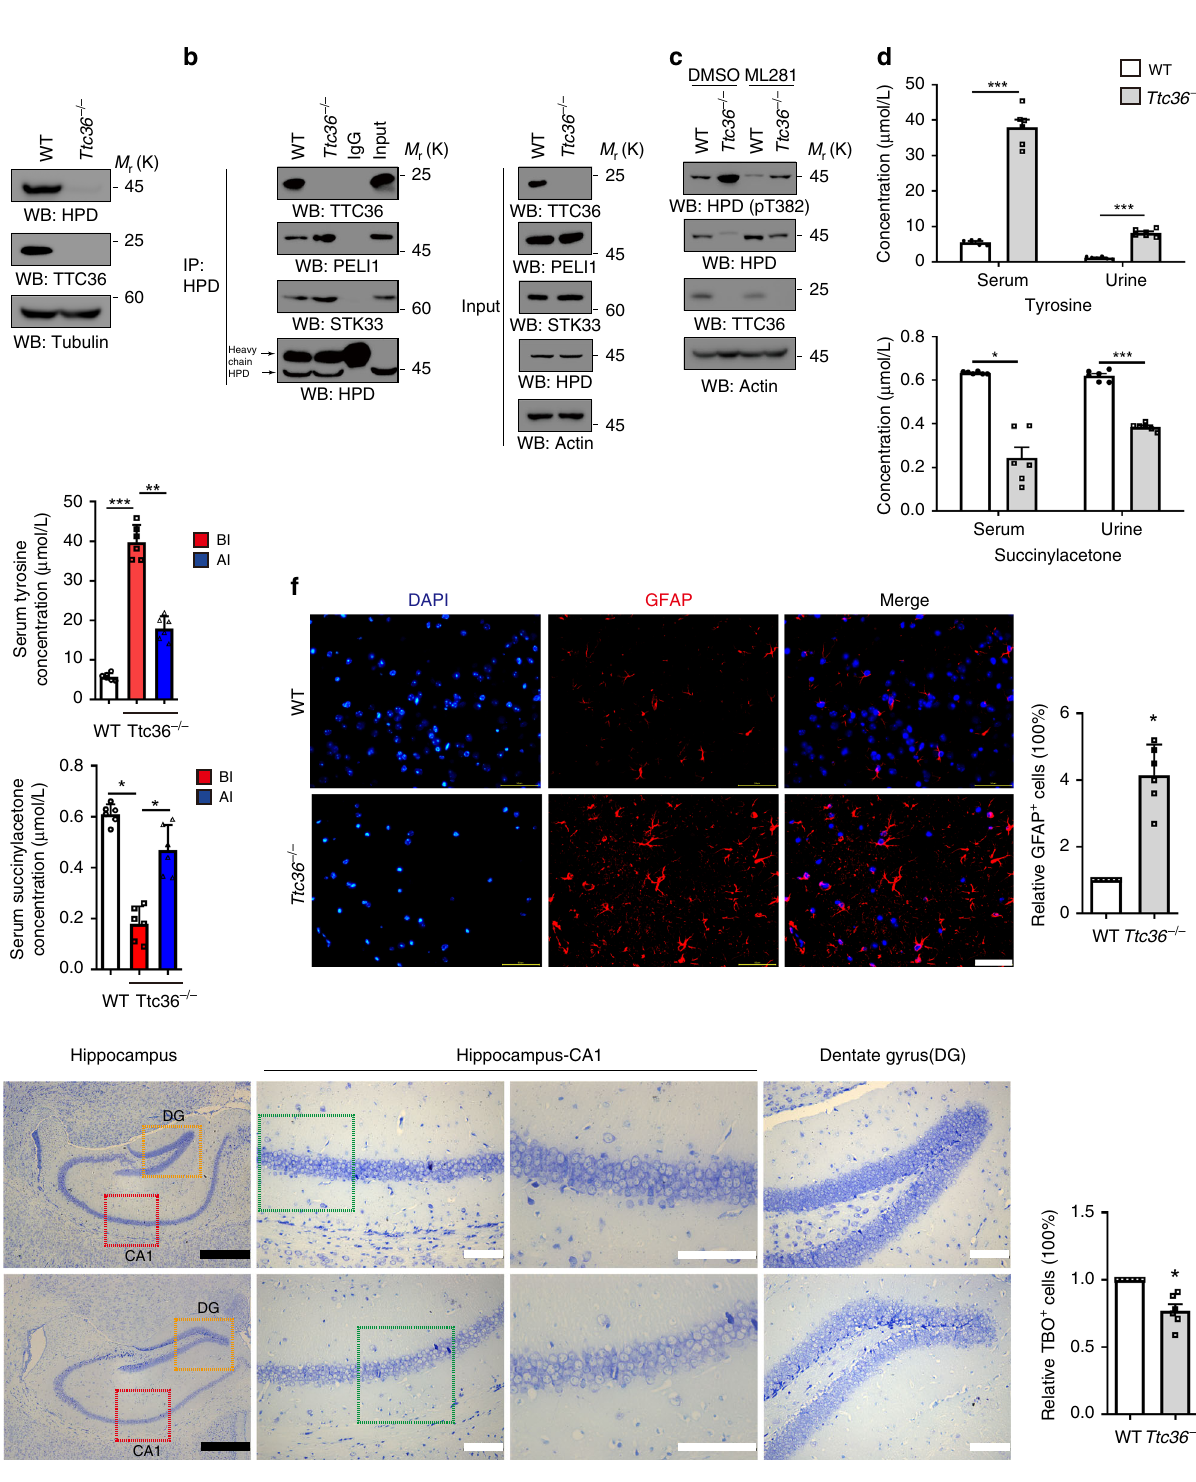
serum and urine (Fig. 5d, lower panel). These alterations were partially reverted by tail vein injection of a TTC36-expressing plasmid (Fig. 5e), and the re-expression of TTC36 in liver was detected by immuno fl uorescence analyses of liver tissues (Supplementary Fig. 5b, c) and immunoblotting analyses of liver lysates (Supplementary Fig. 5d). Glial fi brillary acidic protein (GFAP), which is primarily expressed in astrocyte and markedly upregulated in central nervous system (CNS) injuries 18 , had a much elevated expression level in the Ttc36 − / − mouse brain (Fig. 5f). Although hematoxylin and eosin (H&E) staining did